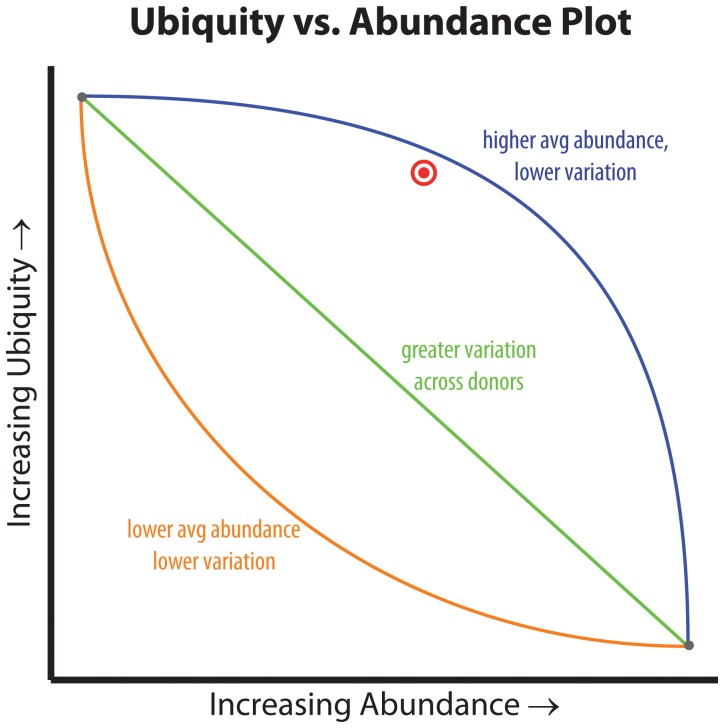
Inflection of the Ub-Ab Curve.The inflection of the Ub-Ab curve describes the distribution of a taxon’s abundance across the cohort. The blue curve (high abundance core) describes a taxon for a cohort with greater average abundance. Since the majority of the cohort had the taxon assayed at a large abundance, the variance will also be lower. The orange curve (minor core) describes a taxon across a cohort assayed with a majority of low abundant measurements. An average of these abundances will yield a smaller value, and because the taxon abundances are concentrated in the low abundance range, the variance will also be lower. The green line represents a taxa assayed with an even distribution of both high and low abundance, thus its variance will be greater than both taxa represented by the blue and orange curves.